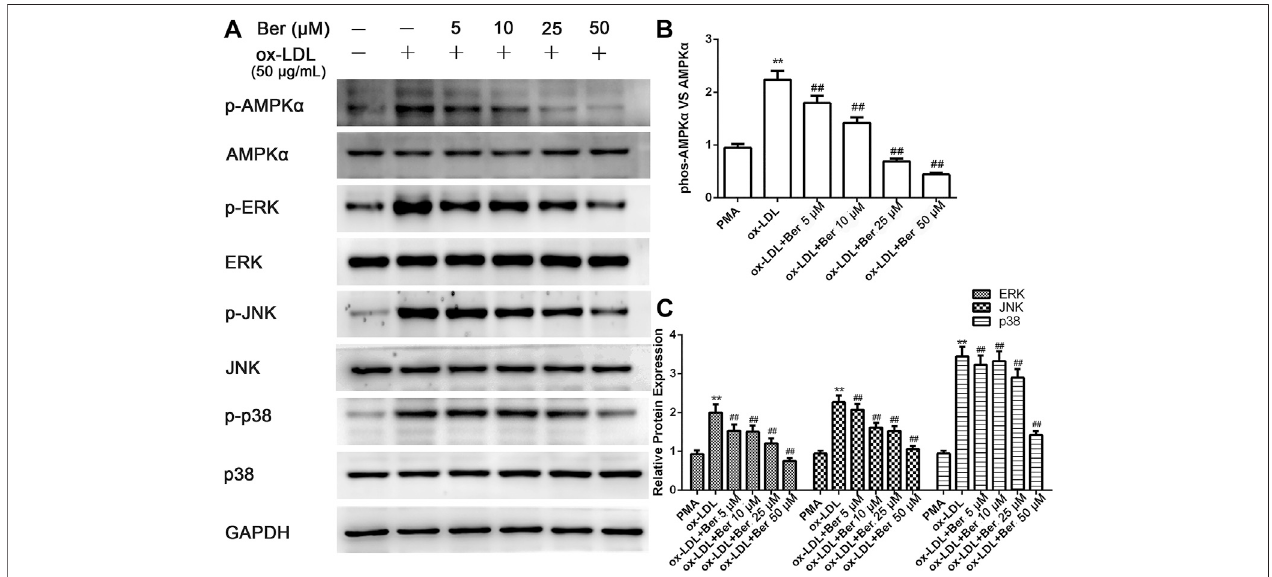
FIGURE 5 | Berberine inhibited the phosphorylation of AMPK α , ERK1/2, p38, and JNK in oxLDL-induced macrophages. The densitometry measurements of phosphorylated AMPK α , ERK1/2, p38, and JNK were normalized to total AMPK α , ERK1/2, p38, and JNK, respectively. The band densitieswere measured by Quantity One 1D analysis software. The data (means ± SD) were obtained from three independent experiments. ** p < 0.01 compared with PMA, ##: p < 0.01 compared with the oxLDL group.